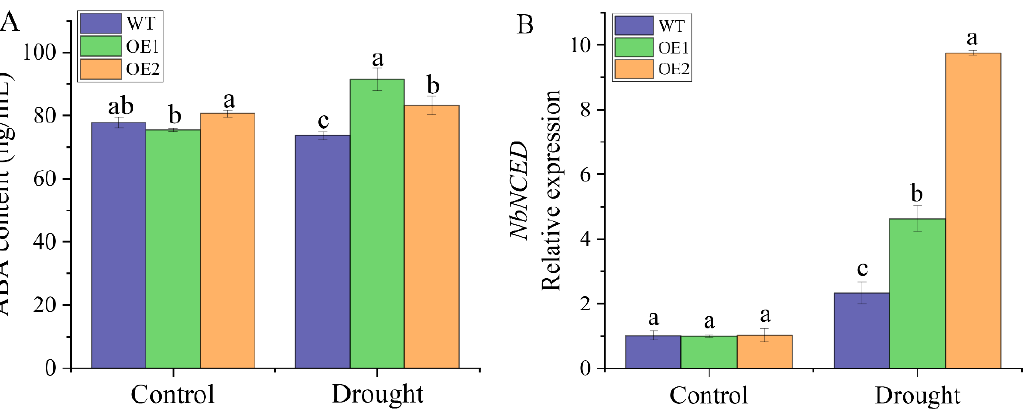
Figure 8. Determination of abscisic acid (ABA) content and expression of its response gene NbNCED in transgenic Nicotiana benthamiana plants overexpressed the ScDREB2B-1 gene under drought stress for 2 d. ( A ) ABA content. ( B ) Relative expression level of ABA responsive gene NbNCED . WT: wild-type N. benthamiana . OE1 and OE2: different transgenic N. benthamiana lines overexpressed ScDREB2B-1. All data points were means ± standard error ( n = 3). Significant differences were found between different letter substitutes on the column calculated by Duncan’s new multiple range test ( p -value < 0.05).